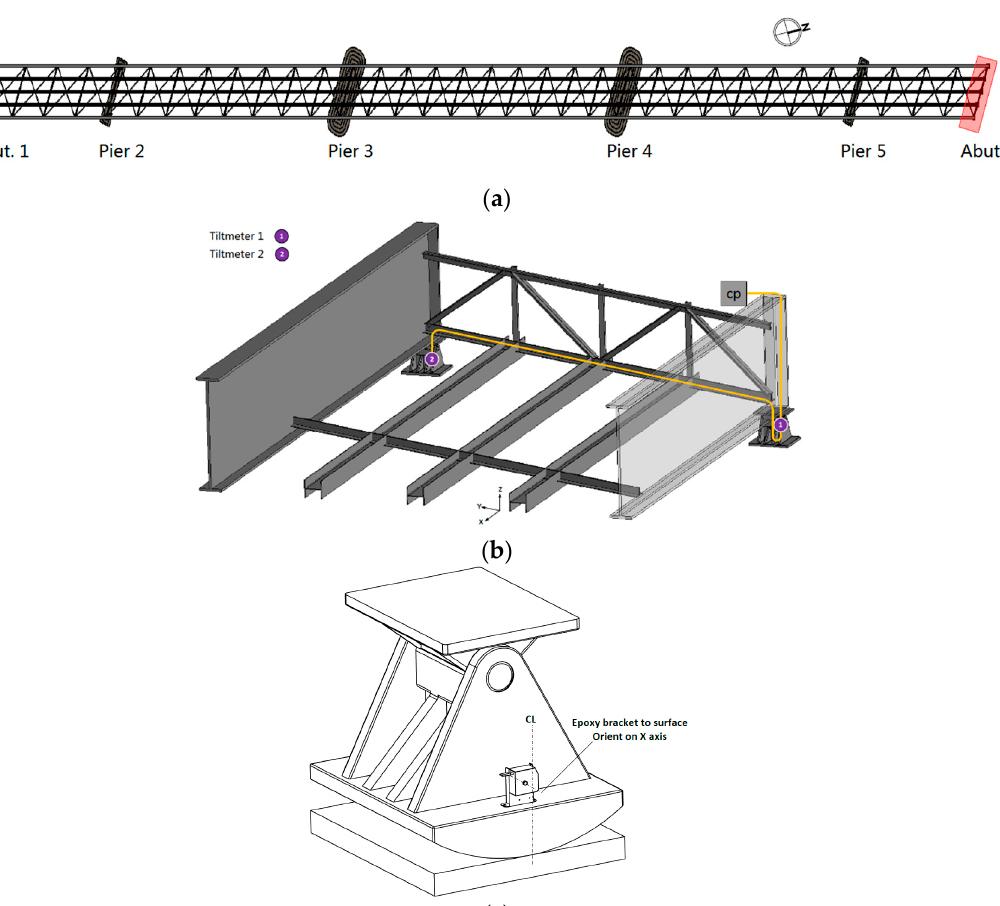
Figure 4. Tiltmeter installation location ( a ) Bridge plan view; ( b ) Abutment 2 view; ( c ) Tiltmeter on expansion bearing.